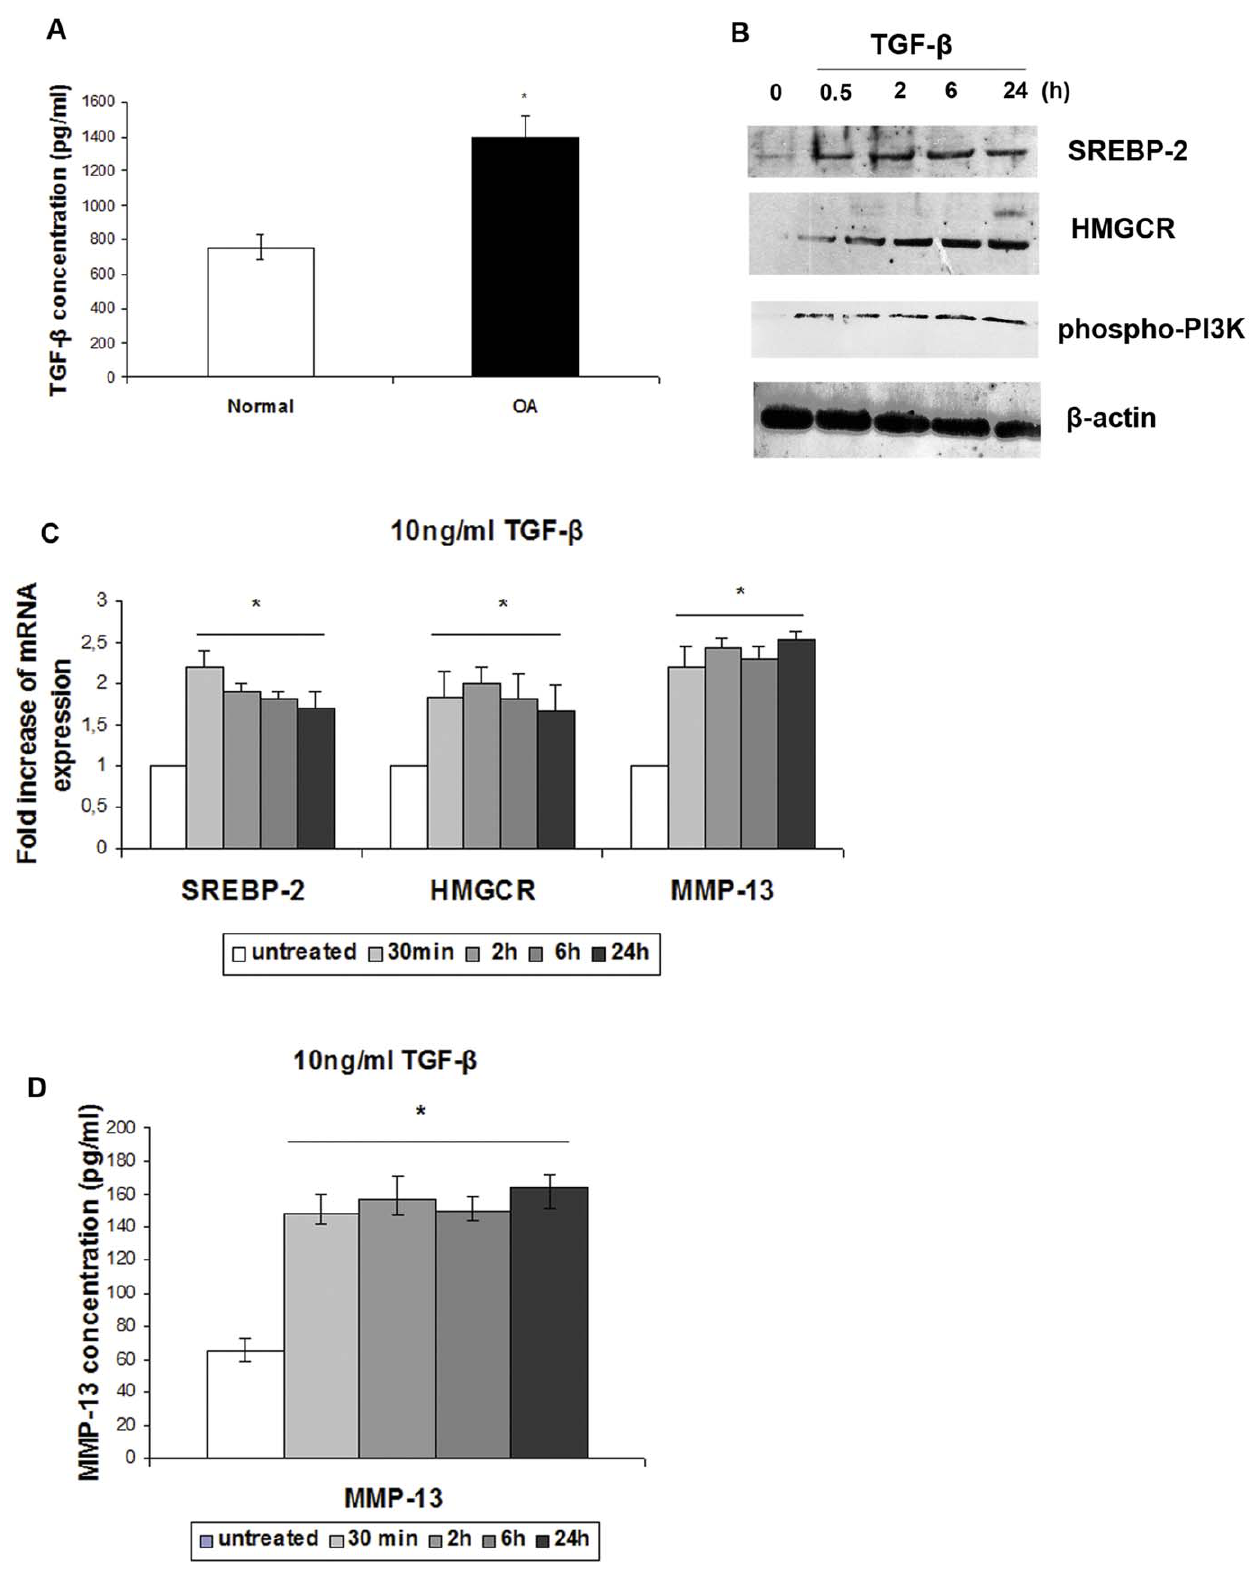
Figure 3. TGF- b expression in normal and osteoarthritic chondrocytes and effect of TGF- b treatment on SREBP-2, HMGCR, phospho- PI3K and MMP-13 expression. ( A ) TGF- b expression levels in normal and osteoarthritic chondrocytes detected by ELISA. *p , 0.05 ( B ) Western blot showing SREBP-2, HMGCR and phospho-PI3K protein expression levels in normal and osteoarthritic chondrocytes treated with 10 ng/ml TGF- b for 0.5, 2, 6, and 24 h. b -actin was used as loading control. The same membrane was reprobed without stripping. ( C ) SREBP-2, HMGCR and MMP-13